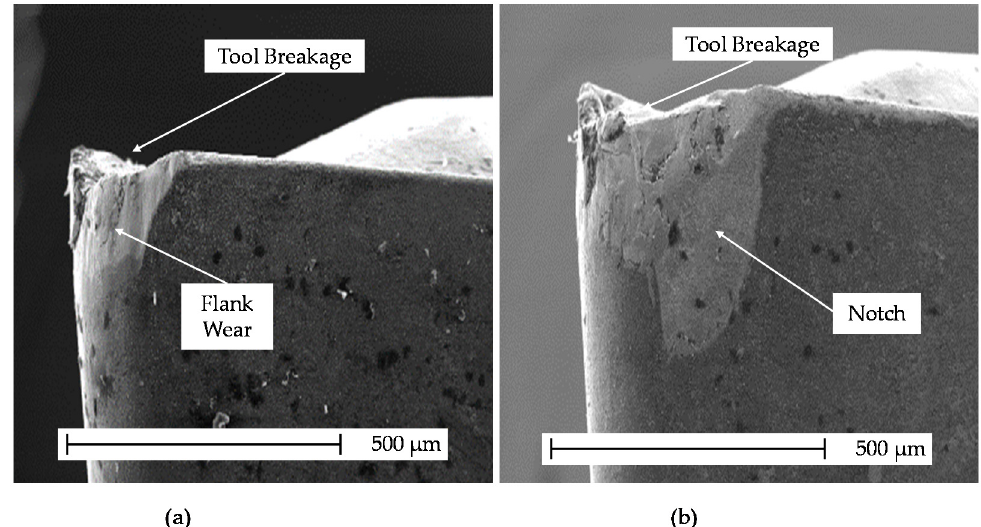
Figure 9. SEM images of the tool at the end of the tool life corresponding to Inconel 718 under conventional pressure with: ( a ) cutting speed 50 m/min and feed 0.1 mm/rev, ( b ) cutting speed 70 m/min and feed 0.15 mm/rev [38].